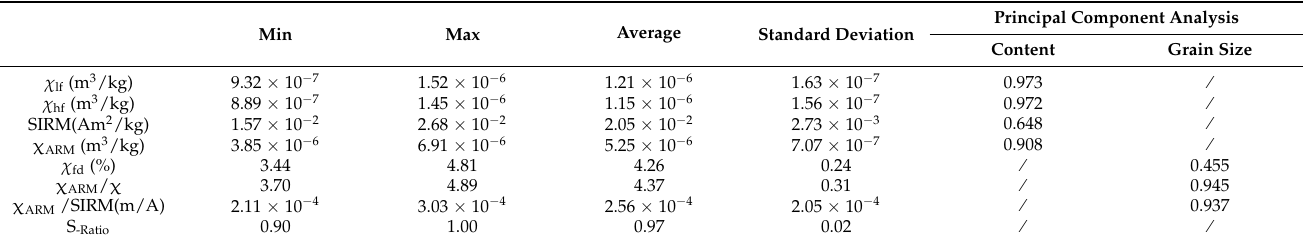
Table 1. Results of magnetic